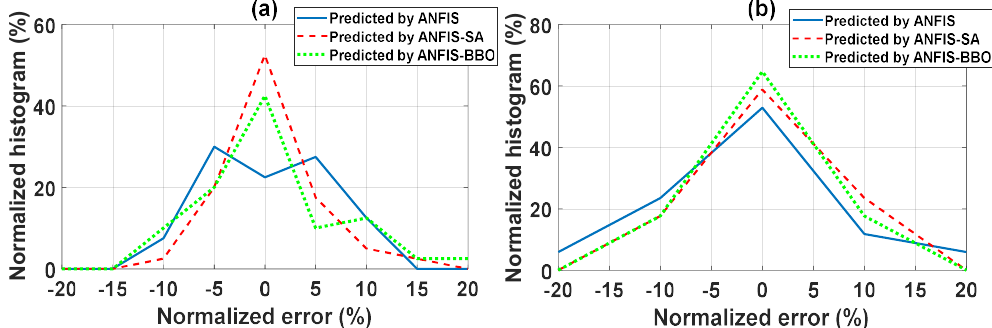
Figure 7. Graphs of normalized error histograms for ( a ) the training part and ( b ) the testing part. Table 3. Summary of prediction capability.